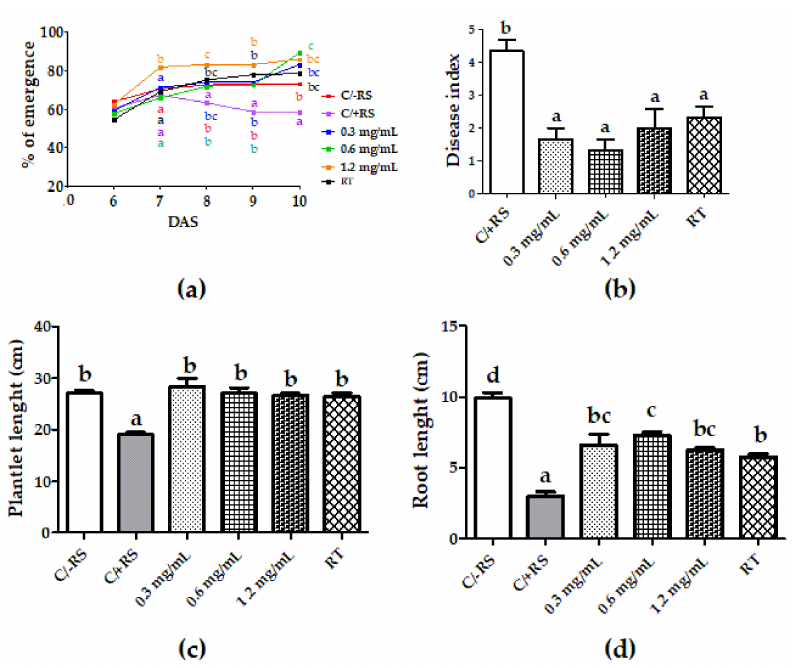
Figure 3. Effect of tomato seed treatment with different concentrations (0.3, 0.6, and 1.2 mg/mL) of Jania adhaerens water-soluble polysaccharides on the emergence percentage of seedlings ( a ), disease severity ( b ), plant length ( c ), and root length ( d ) in a growing substrate infected with Rhizoctonia solani (RS). C/-RS = non infected control; C/+RS = infected control; RT = reference treatment (2 mL/L); DAS = days after sowing. In panel ( a ), each value is the mean of 3 independent experiments ( n = 3); different letters indicate significant differences among treatments and controls within each DAS, according to the LSD test ( p < 0.05). In panels ( b – d ), columns are mean values of 3 independent experiments ( n = 3) ± SD. Different letters indicate significant differences among treatments and controls according to the LSD test ( p < 0.05).